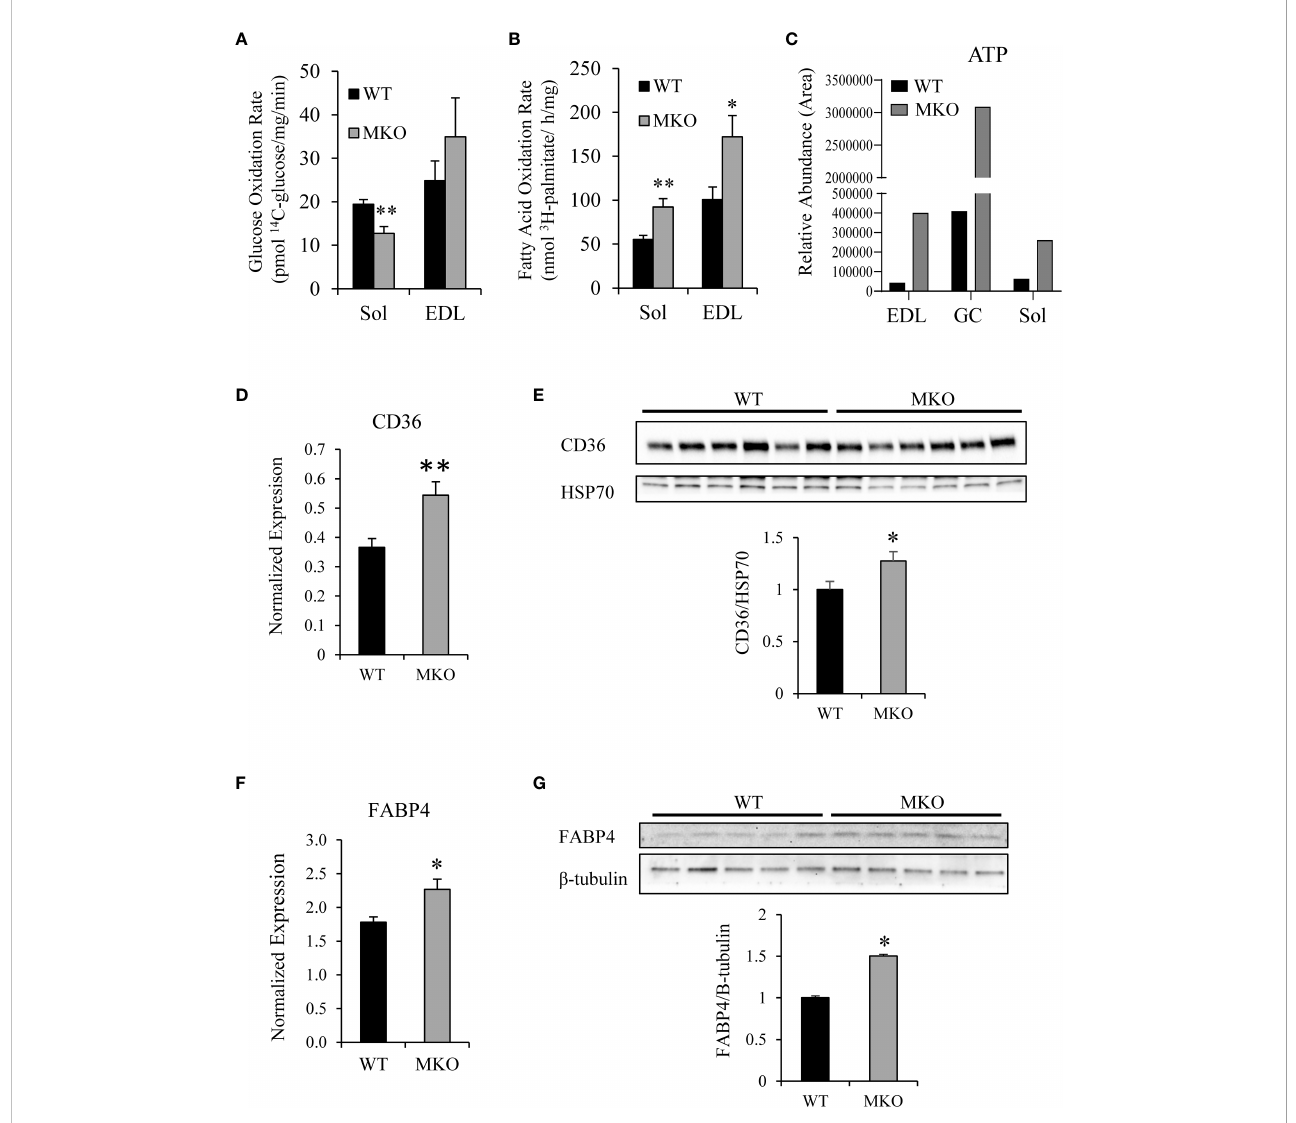
FIGURE 3 Arid5b MKO skeletal muscles preferentially utilize fatty acids. (A) Glucose oxidation rates were determined in isolated skeletal muscles by measuring 14 CO 14 C-glucose. (Sol, n=6; EDL, n=5). **, p < 0.01. (B) Palmitate oxidation rates were determined in isolated skeletal 2 release after incubation with muscles by measuring 3 H 2 O release after incubation with 3 H-palmitic acid. (Sol, n=6; EDL, n=5) *, p < 0.05; **, p < 0.01. (C) Mass spectrometry